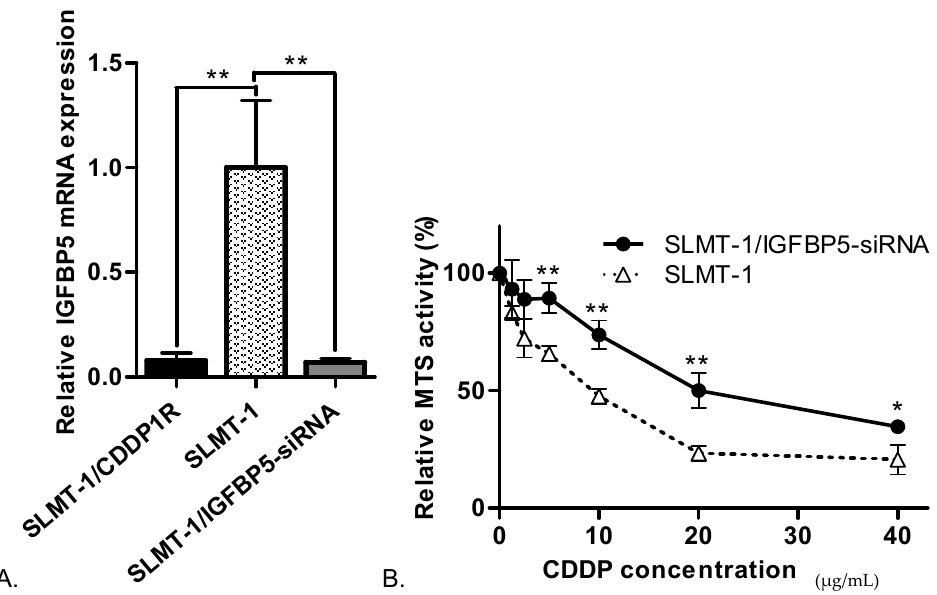
Figure 3. Association of IGFBP-5 downregulation and cisplatin-resistance. ( A ) Relative expression levels of IGFBP5 in SLMT-1/IGFBP5-siRNA cells was significantly lower than SLMT-1 cells. Relative IGFBP5 expression levels were determined by comparing with SLMT-1 cells, after normalized with expression of β -actin. ** p < 0.01. ( B ) Relative MTS activities of SLMT-1 and SLMT-1/IGFBP5-siRNAcells after 48 h treatment with cisplatin at different concentrations (0, 1.25, 2.5, 5, 10, 20 and 40 µ g/mL). Relative MTS activities were expressed as means ± standard error compared with the MTS activities at zero CDDP concentration and analyzed using one-way ANOVA. SLMT-1/IGFBP5-siRNA was compared to SLMT-1 with * p < 0.05 and ** p < 0.01 IGFBP5-siRNA was effective in inducing the significant proliferation of SLMT-1 cells under the CDDP treatment.